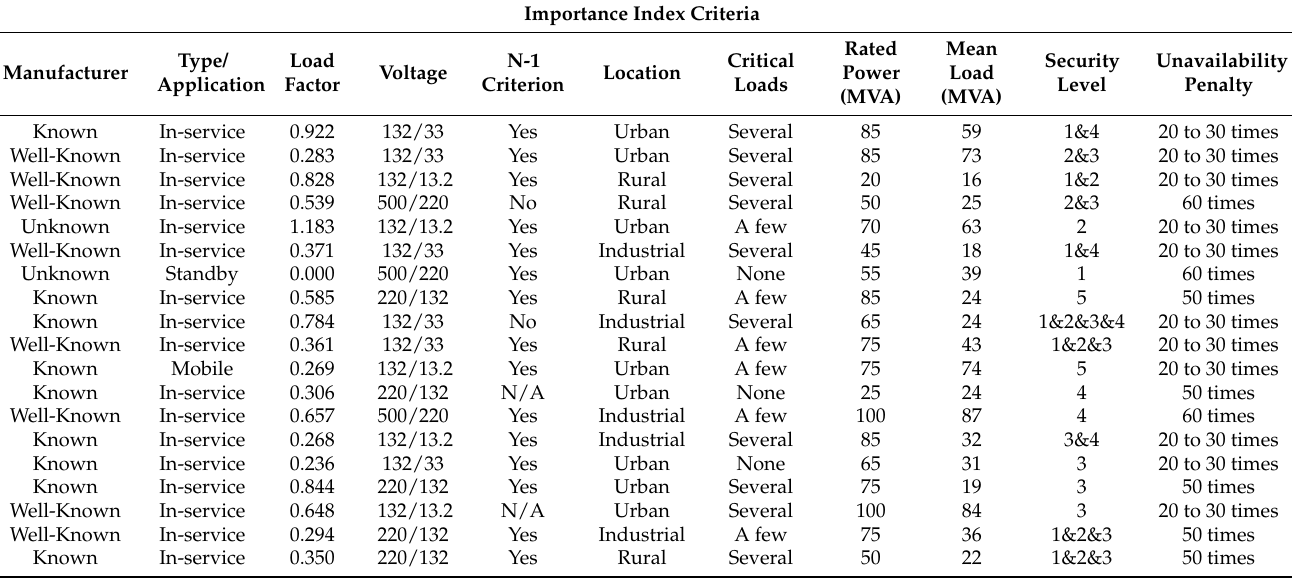
Table 3. Transformers fleet operative features.